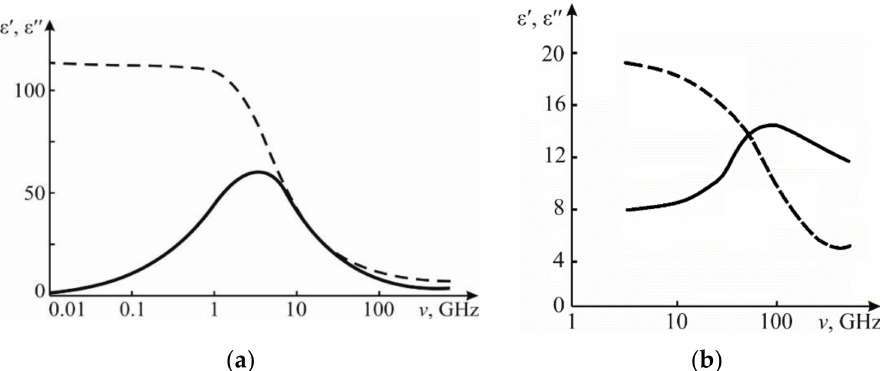
Figure 5. Microwave dispersion and absorption in order–disorder-type ferroelectrics: ( a ) Rochelle salt, RS = KNaC 4 H 4 O 6 · 4H 2 O; ( b ) triglycine sulfate, TGS = (NH 2 CH 2 COOH) 3 · H 2 SO 4